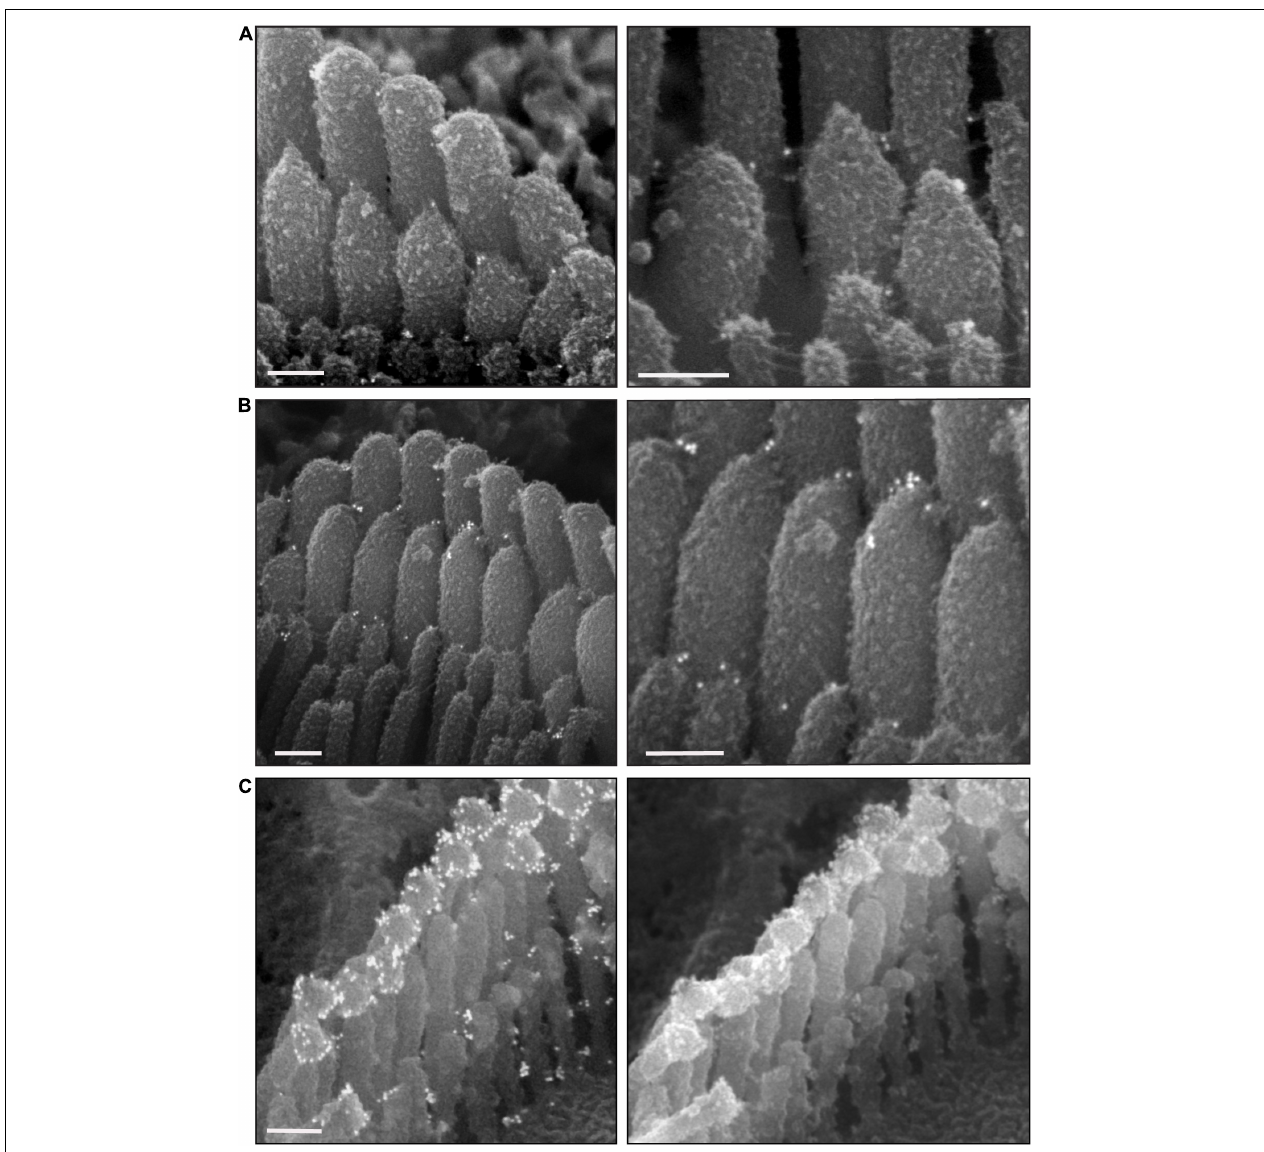
FIGURE 5 | Representative immunogold scanning electron micrographs of OHC hair bundles of the neonatal (P6) wild-type mouse cochlea. Samples in (A,B) were immunostained with anti-PCDH15 primary antibody and gold-conjugated secondary antibody, sputter-coated with 5 nm palladium, and imaged with backscatter electron detectors on different microscopes. (A,B) Were prepared in parallel. Gold beads (12 nm) localize mostly at the tips of shorter-row stereocilia. (A) Sample imaged with a field-emission SEM (Hitachi S-4700) using BSE detection mode (semiconductor BSE detector). Right panel is higher magnification. (B) Sample imaged with a field-emission FEI Helios 660 FIB-SEM using BSE detection mode (high contrast solid-state BSE detector, CBS). Right panel is higher magnification. (C) Sample was immunostained with anti-STRC primary and gold-conjugated secondary antibodies, using a protocol similar to that in methods, and imaged (left) with a Helios 660 FIB-SEM using BSE or (right) with a Hitachi S-4700 using SE detectors. Scale bars: (A–C) 200